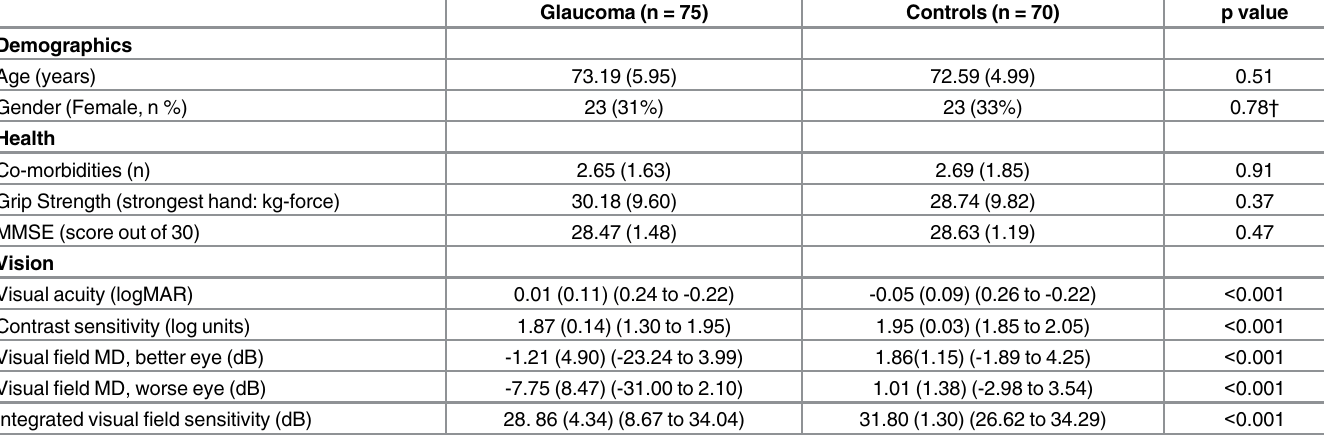
Table 1. Demographic and visual characteristics of the participants by group. Continuous variables presented in mean ± SD, with minimum to maxi- mum values given for the vision